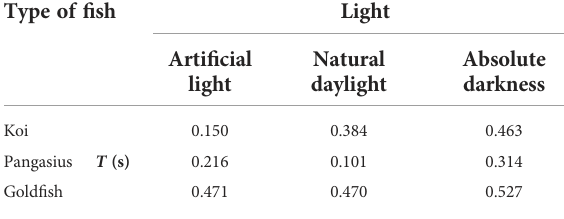
FIGURE 7 Dissipation rates of the fl ow generated by the schools of koi, pangasius, and gold fi sh as a function of abundance. The broken lines are least-squares linear regressions fi tted to the data.